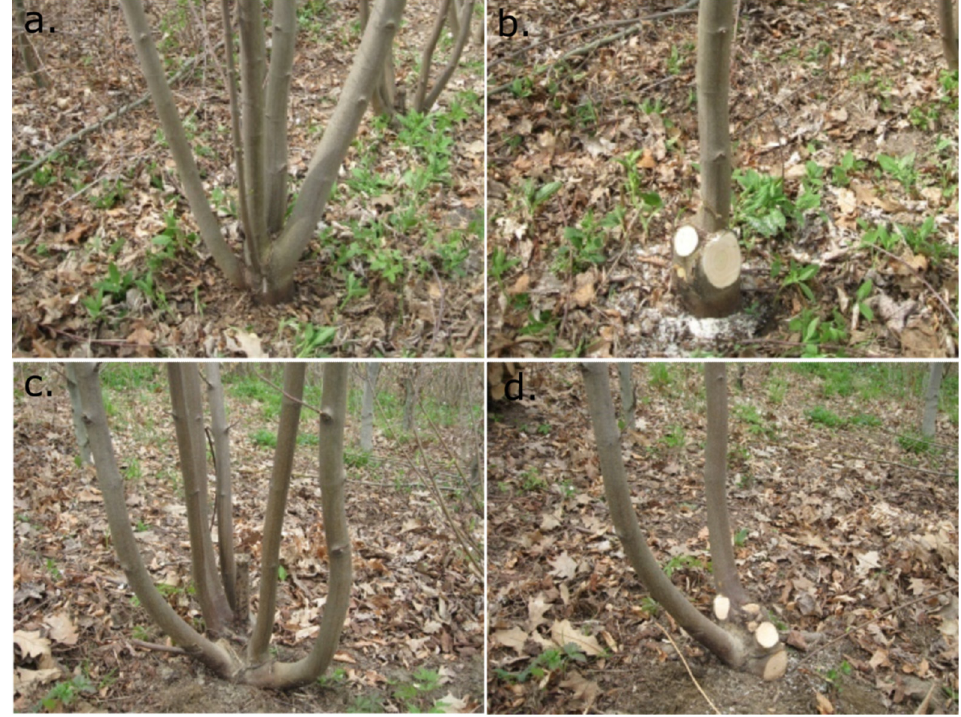
Figure 3. Treatment of stumps with one shoot (( a ) before cut and ( b ) after cut) and two shoots (( c ) before cut and ( d ) after cut) . before cut and ( d ) after